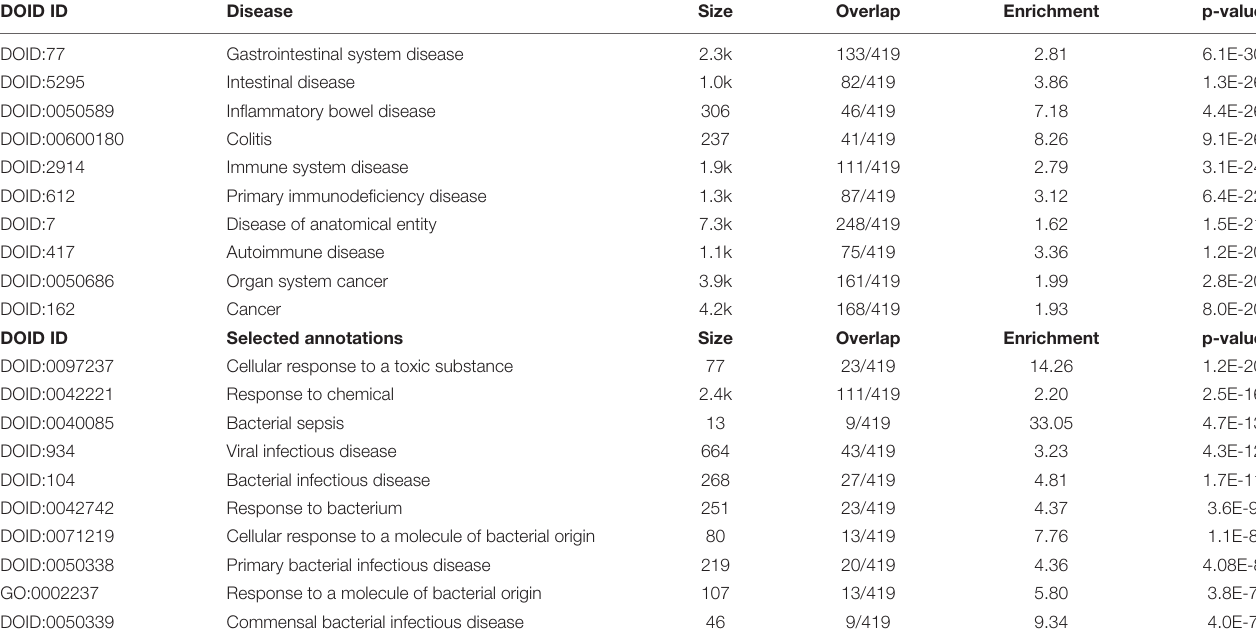
TABLE 5 | Results of inBio discover annotation analysis with the top 10 and custom-made DOID annotations associated with chronic fatigue spectrum disorders. DOID